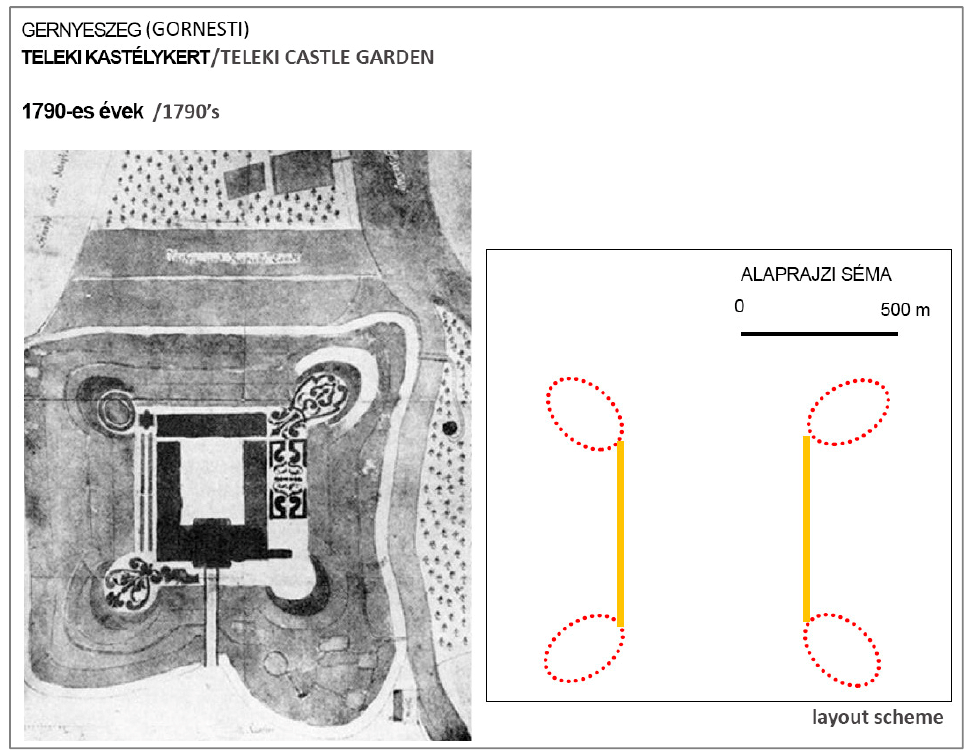
Figure 9. The Baroque garden design for the Teleki Castle Garden in Gernyeszeg (Gornesti, RO) from 1792. Source: compiled by Albert Fekete based on “ A gernyeszegi francia kert tervrajza ” [33].